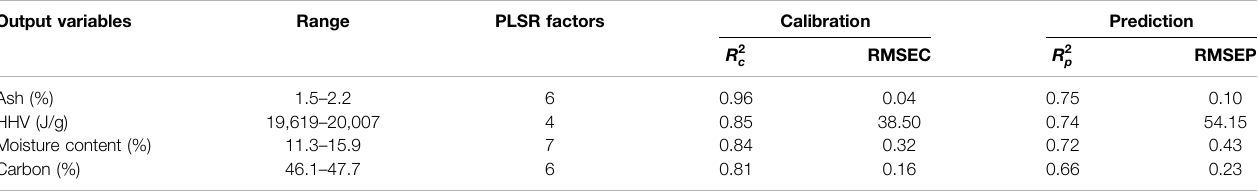
TABLE 6 | Performance of PLSR models for predicting pellet properties during 2.5-ton demonstration using at-line NIR spectroscopy (950 – 1,650 nm region) and pelleting process data. Output